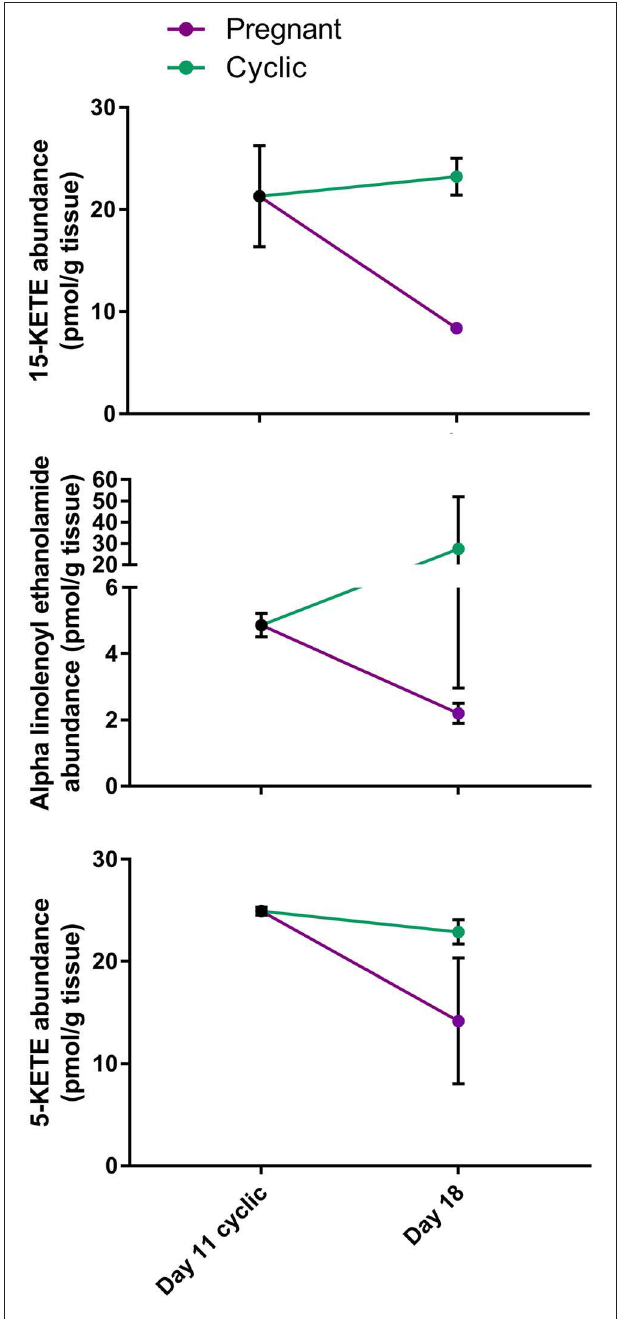
FIGURE 6 | Comparison of lipid abundance on day 11 of the estrous cycle and day 18 of pregnancy. Mean lipid abundance on day 11 is represented by a black circle, with day 18 of the estrous cycle represented in teal and day 18 of pregnancy represented in purple. 15-KETE and alpha-linolenoyl ethanolamide differed ( P < 0.05) when day 11 of the estrous cycle and day 18 of pregnancy were compared, while 5-KETE demonstrated a similar numerical pattern ( P =